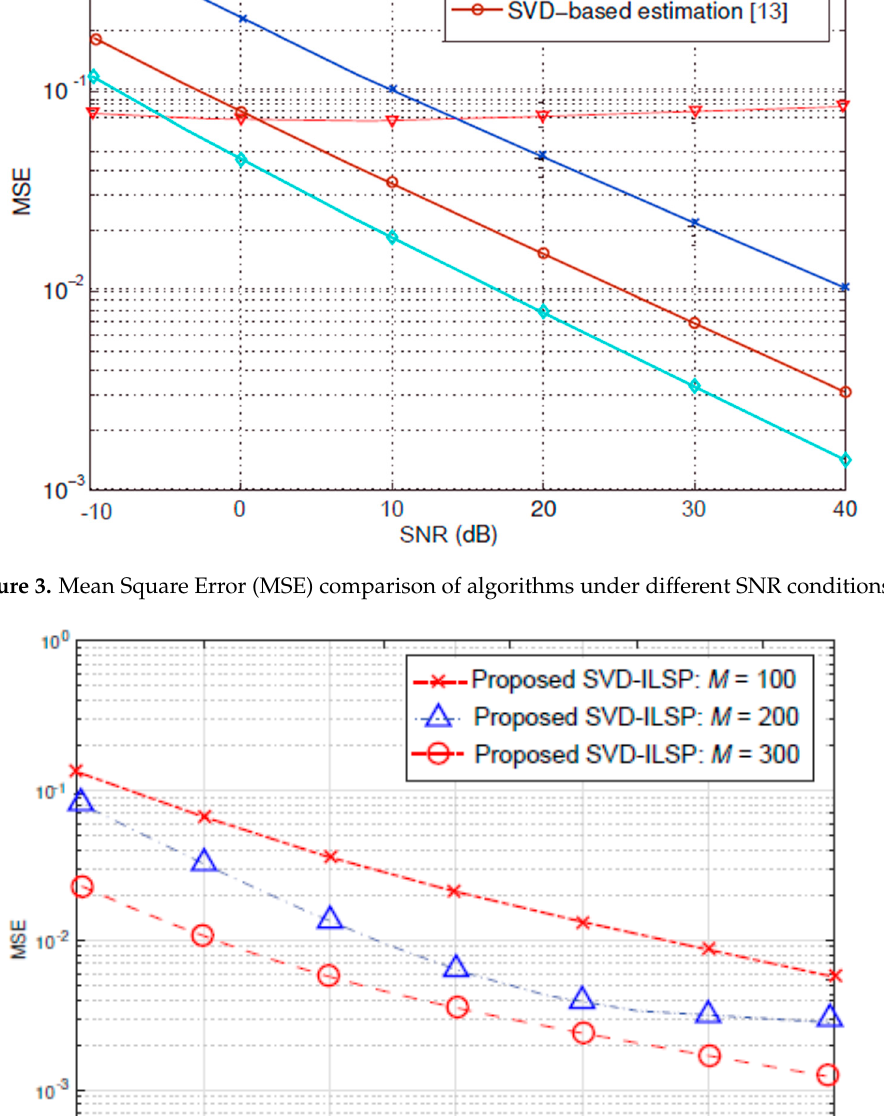
Table 2. Simulation Parameters.